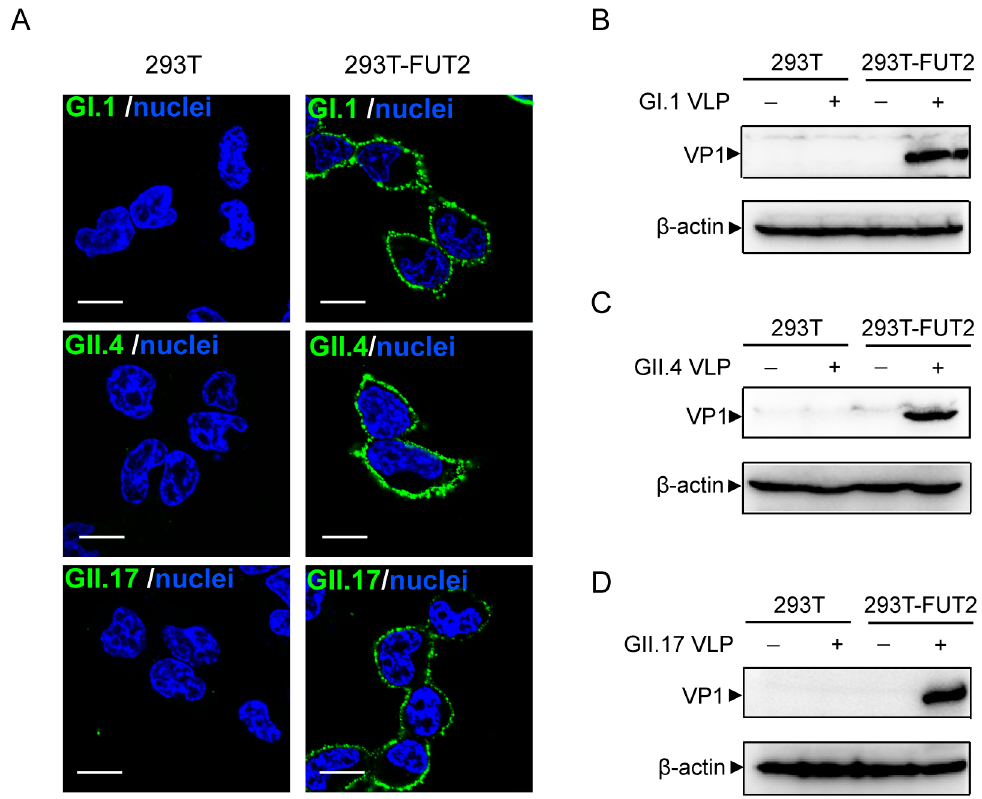
Figure 3. Binding of norovirus virus-like particles (NoVs VLPs) to 293T-FUT2 cells. NoV VLPs were incubated with 293T and 293T-FUT2 cells for 1 h at 4 °C and subjected to immunofluorescence and Western blot analyses with mouse antisera against GI.1, GII.4, or GII.17 VLPs. β -Actin was chosen as an internal control. ( A ) Immunofluorescence analysis of NoV VLPs binding to 293T-FUT2 cells. Scale bar, 10 μ m. ( B – D ) Western blot analysis of NoV VLPs binding to 293T-FUT2 cells. All of the